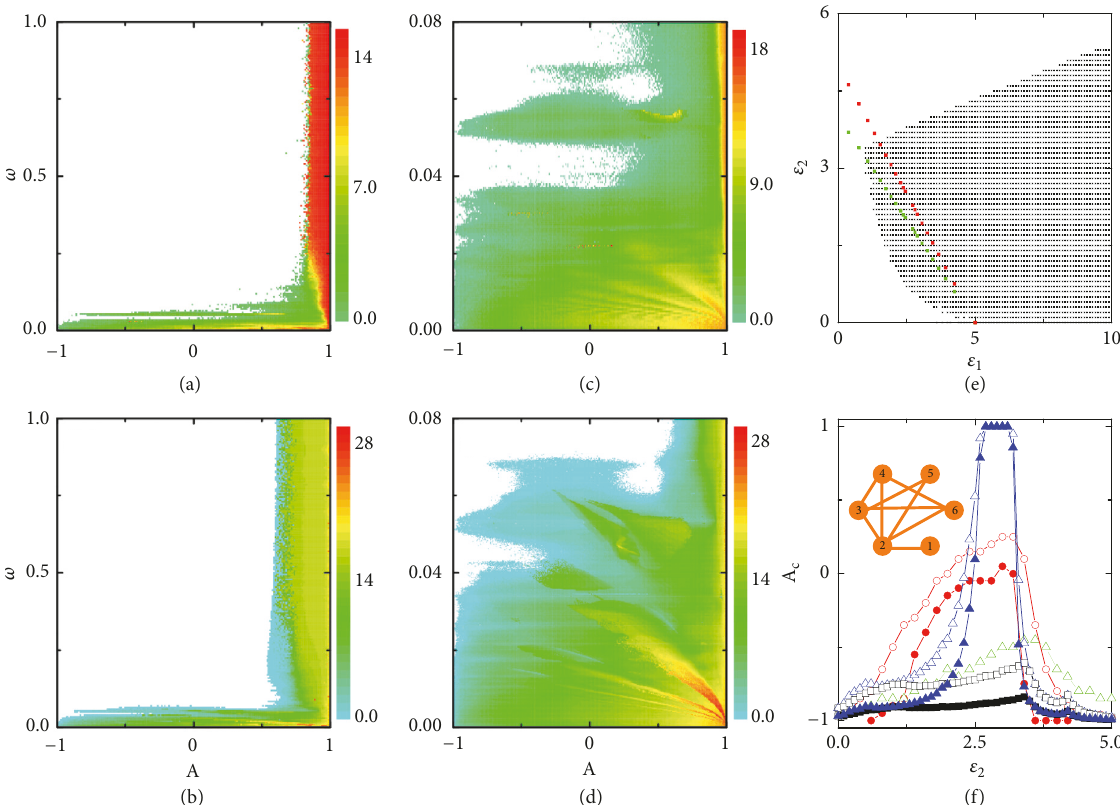
Figure 3: The contour plot of the synchronization error Δ in the plane of 𝐴 and 𝜔 in (a) for 𝜀 1 = 5 and 𝜀 2 = 4 and in (b) for 𝜀 1 = 5 and 𝜀 2 = 5 . (c) and (d) The enlargement view of (a) and (b) in the range of 𝜔 ∈ (0,0.08) , respectively. (e) The phase diagram in the plane of 𝜀 1 and 𝜀 2 for the time-independent duplex network with two layers represented by 𝐿 (1) and 𝐿 (2) . The shaded area corresponds to the CS region. The dot lines denote the effective 𝜀 1,𝑒 and 𝜀 2,𝑒 acquired by the fast-switching approximation. (f) The critical 𝐴 are plotted against 𝜀 2 with 𝐴 ∗ 1 in black, 𝐴 ∗ 𝐴 𝐴 𝜀 𝑐 acquired from the synchronization error in red. In addition, 𝑐 against 2 in the time-dependent duplex network with 2 in blue, and = 5 for the solid symbols and 𝜀 = 6 for the open symbols. The inset in (f) shows the single-layer 𝐿 (2) replaced by 𝐿 (3) is plotted in green. 𝜀 1 1 network 𝐿 (3)